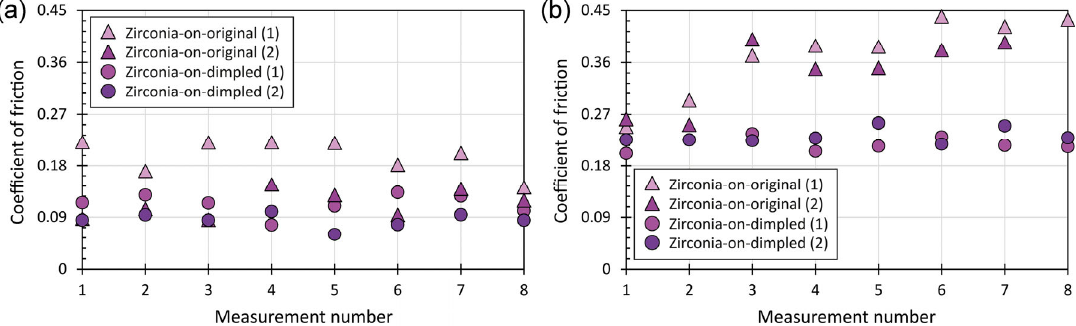
Fig. 6 Results of friction coefficient for zirconia toughened ceramic femoral head using (a) PBS and (b) model SF.